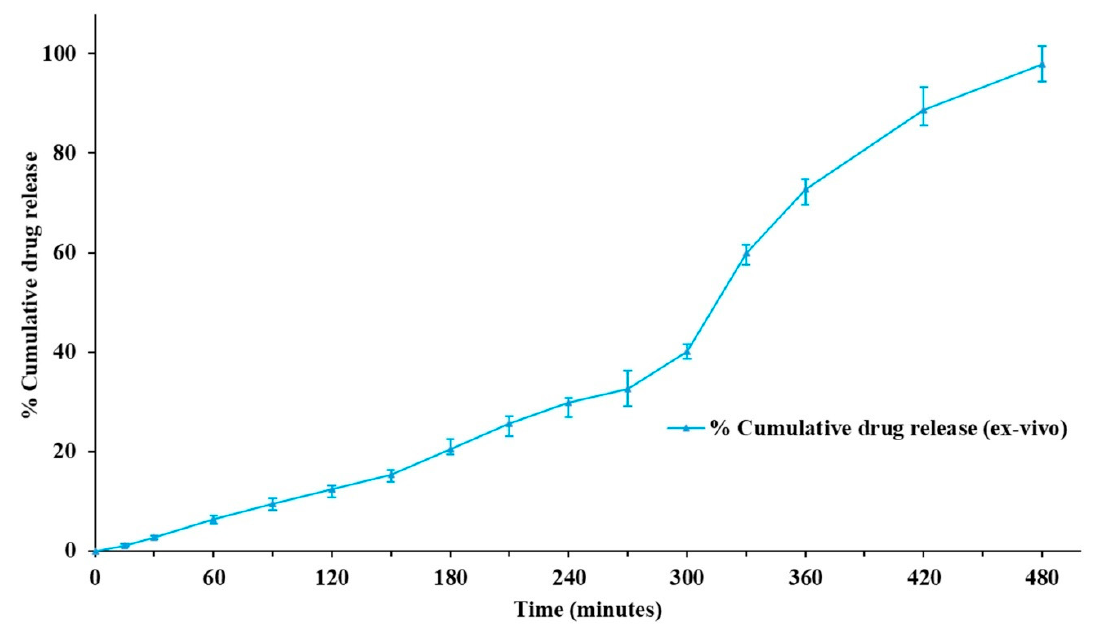
Figure 10. Ex vivo diffusion studies of optimized transemulgel Figure 10 . Ex vivo diffusion studies of optimized transemulgel formulation.